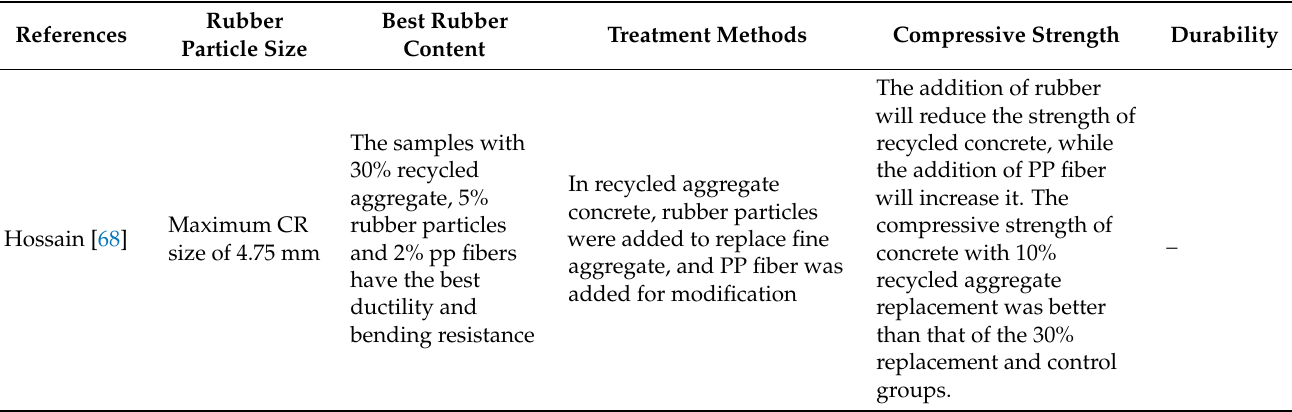
Table 9. Summary table of incorporating